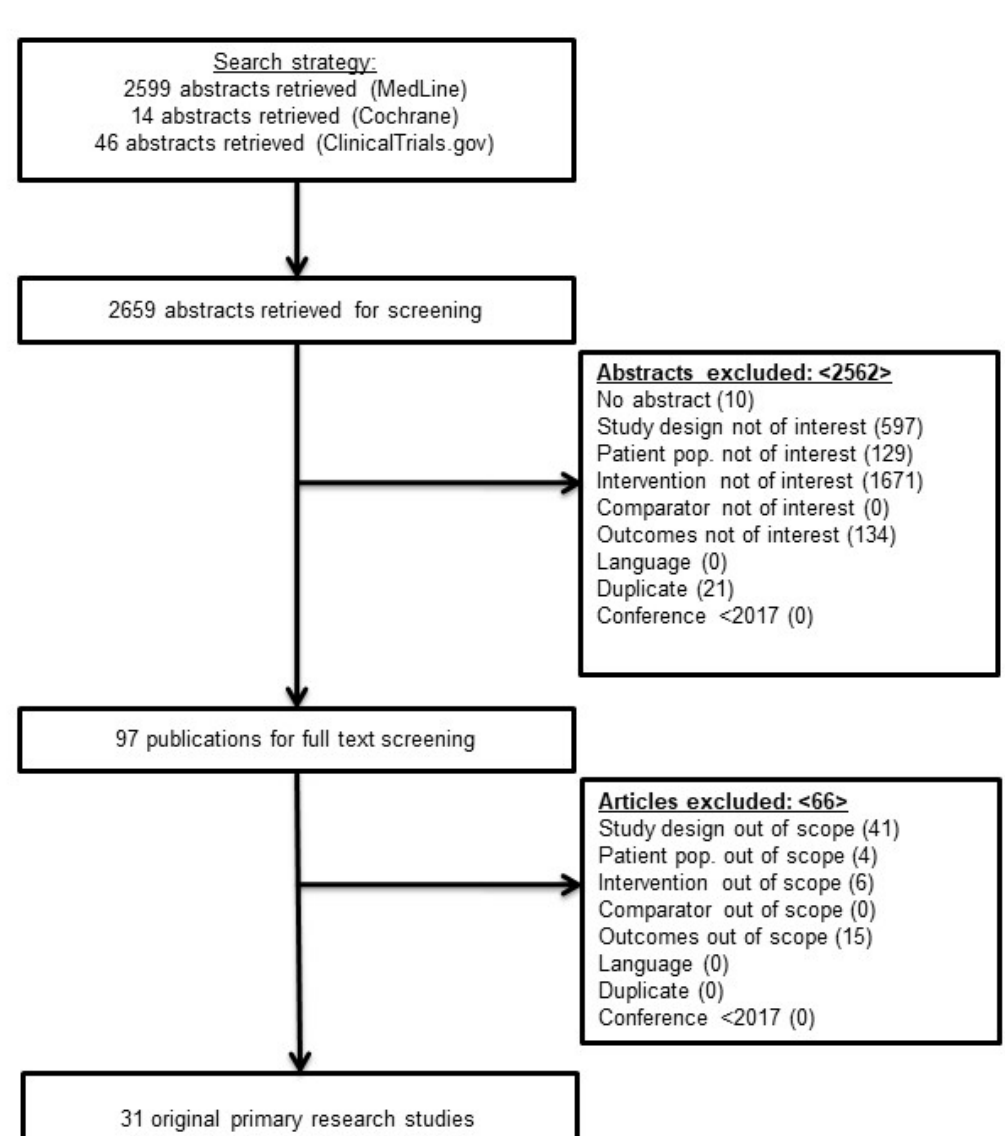
Figure 3. Study selection - infection or sepsis. Pop. =